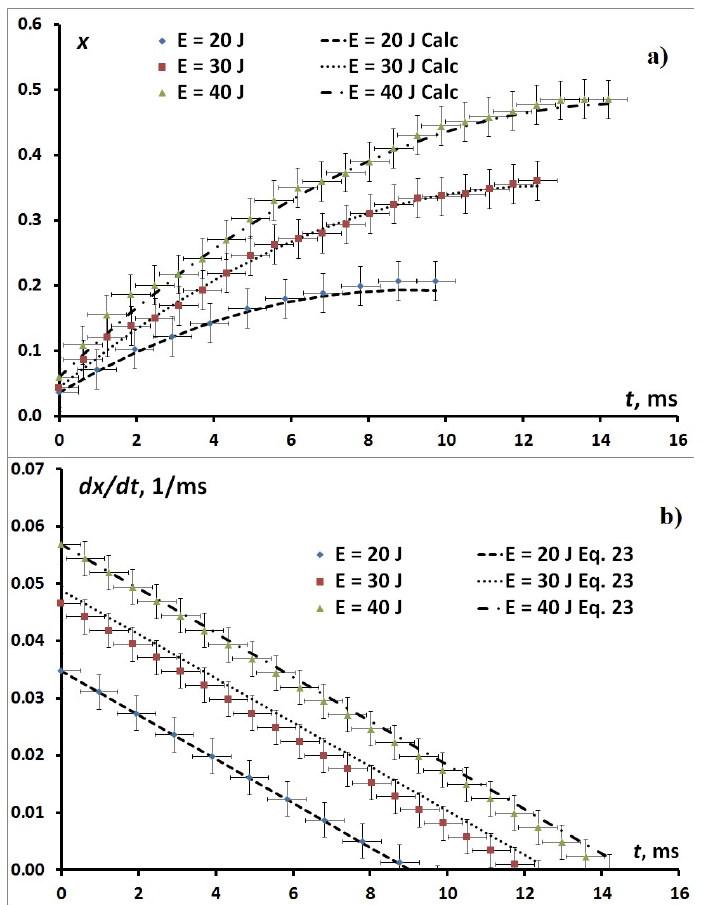
Figure 3. The experimental time dependencies of ( a ) the fracture of filled pore volume x ( t ) and calculated using the Formula (23) and ( b ) normalized flux with calculations in accordance with the (23). The time is counted from the time t 2 reaches the pressure P 0